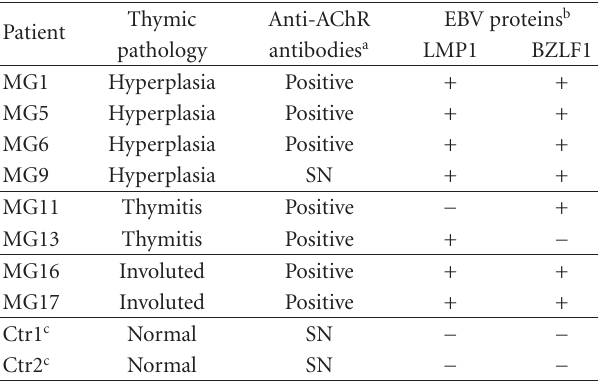
Table 4: Detection of EBV latent LMP1 and lytic BZLF1 proteins in MG thymus by